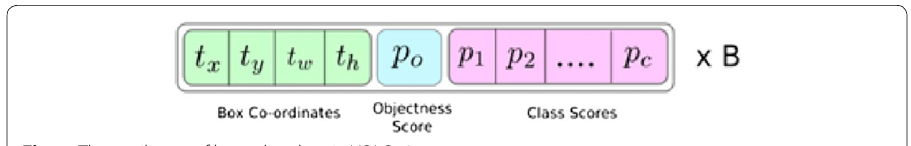
Fig. 1 The attributes of bounding box in YOLOv3